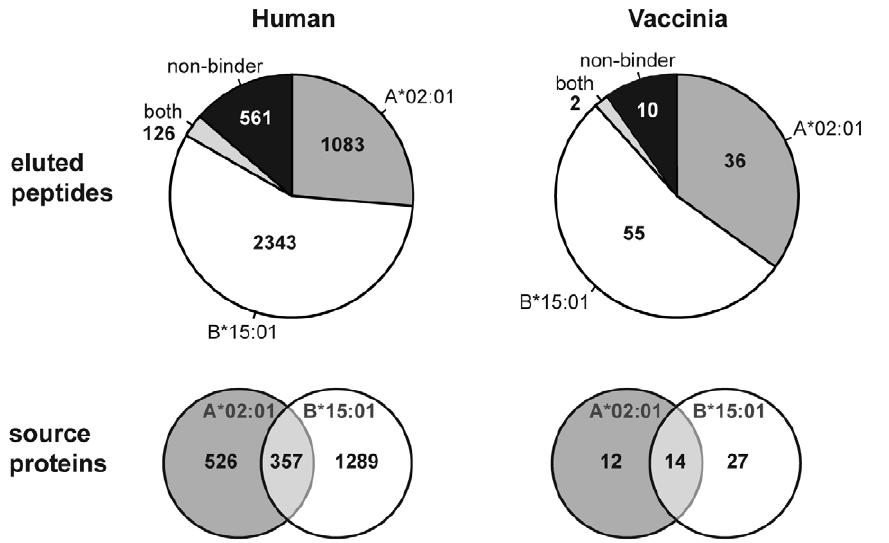
Figure 1. Composition of the Johnson data. The pie charts depict the fractions of eluted peptides that were predicted to bind to HLA-A*02:01, B*15:01, both, or neither of the two alleles. Predictions were only performed for peptides of 8–13 amino acids in length ( n =4113 for human-derived peptides, n =103 for vaccinia). The Venn diagrams indicate the number of source proteins these peptides originated from.